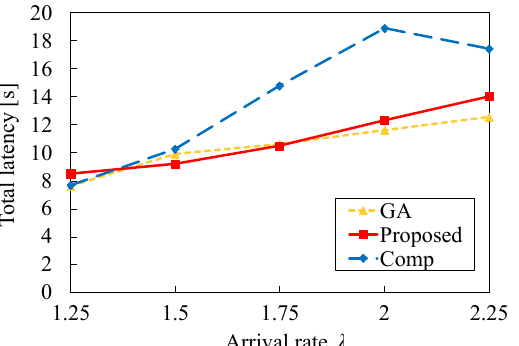
Figure 13. Total latency versus arrival rate λ in the case of N 1 = 50 and τ = 0.2.